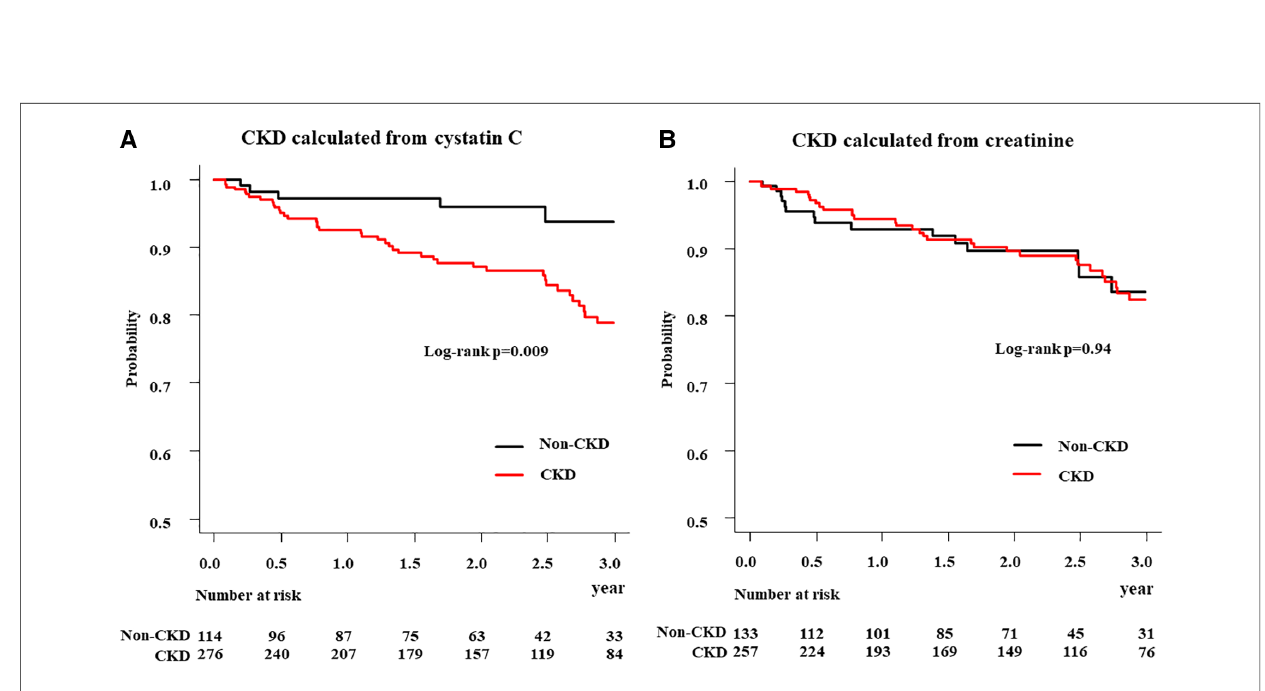
FIGURE 3 Kaplan – meier analysis of all-cause mortality in patients in CKD and non-CKD groups. ( A ) CKD calculated from cystatin C ( B ) CKD calculated from creatinine; CKD, chronic kidney